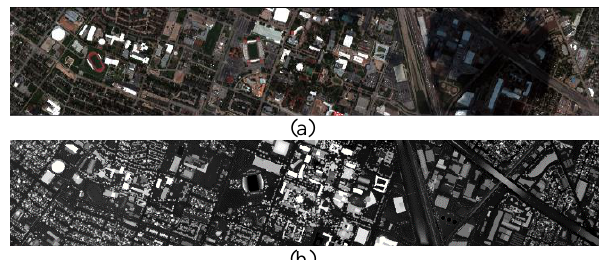
Figure 2.data sets: a) Hyperspectral Image, b) Lidar derived DSM